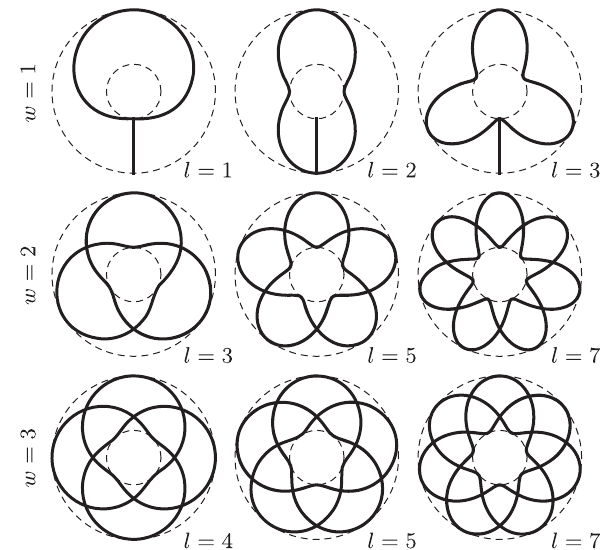
FIG. 12. Illustration of the winding number w and the length parameter l ; see Eq. (B1). Each plot indicates the projection of the cluster lane ’ s midline onto the torus ’ s equatorial plane. (The system ’ s extent in the equatorial plane is indicated by a pair of dashed, concentric circles.) The winding number w (rows) gives the number of full revolutions about the torus ’ s midpoint in the equatorial plane. The special case w ¼ 0 is indicated by the straight solid lines in the top row. The length parameter l (columns) gives the total length of the closed contour represent- ing the cluster lane ’ s